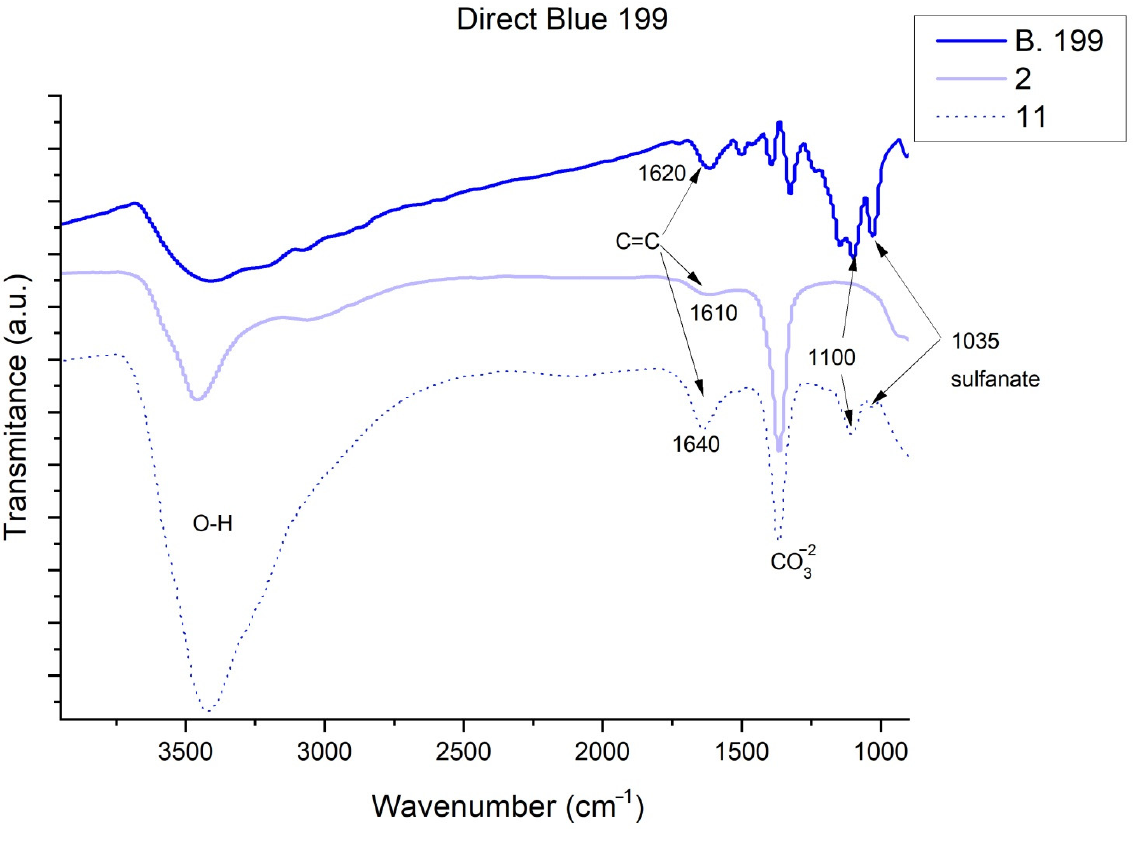
Figure 13. FTIR of Direct Blue 199, Sample 2 and Sample 11. The FTIR spectra of Direct Red 23 are shown in Figure 15. The peaks at 3308 and 3426 cm − 1 correspond to the phenolic -OH, C-N stretching and water could be clearly observed [62–64]. Another peak is observed at 1600–1610 cm − 1 , which corresponds to the aromatic groups -C = C, while the peak at 1180–1170 cm − 1 indicates the presence of single bonds of CO and OH [62–66]. The peak shown at 1480–1500 is characteristic of the azo bond [60]. Another significant peak appears at 1050 cm − 1 , which corresponds to the bonds formed by the S-O [67,68] corresponding to the sulfonate groups -SO 3 from the NaSO 3